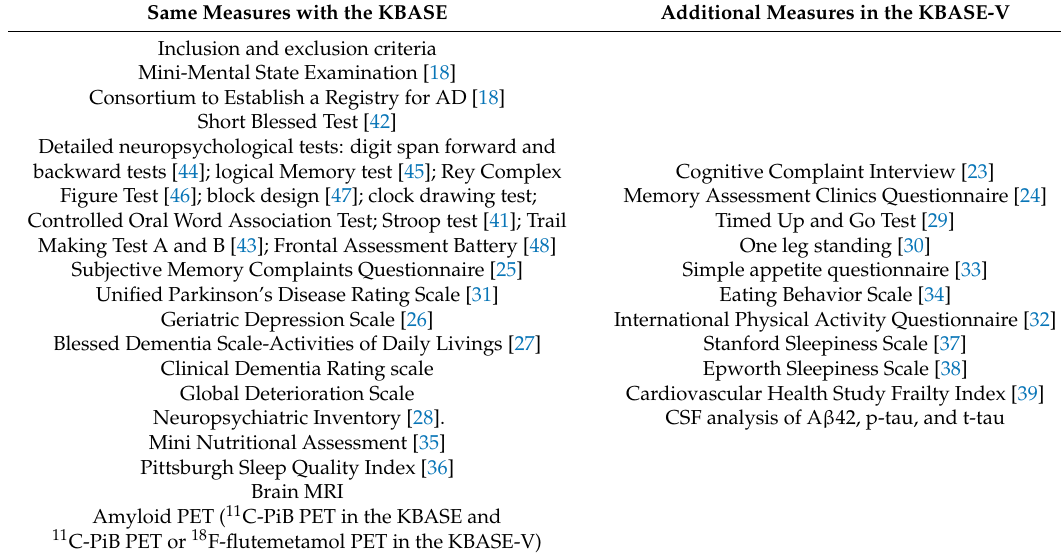
Table 1. The same measures with the Korean Brain Aging Study for the Early Diagnosis and Prediction of AD (KBASE) and the additional measures of the validation cohort of KBASE (KBASE-V).